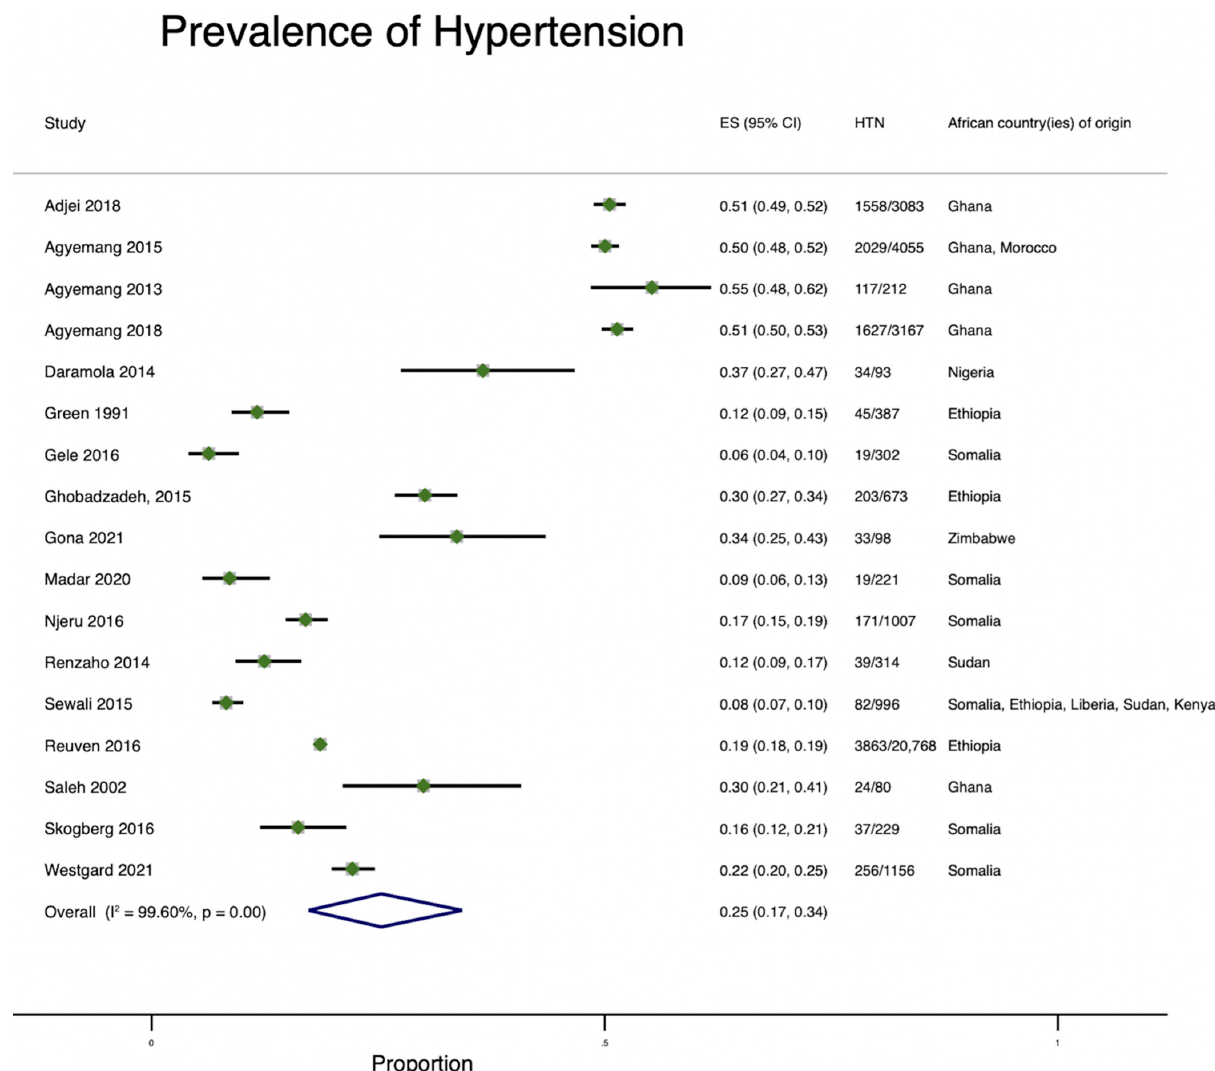
Figure 3. Pooled prevalence of hypertension among African immigrants residing in high-income countries.